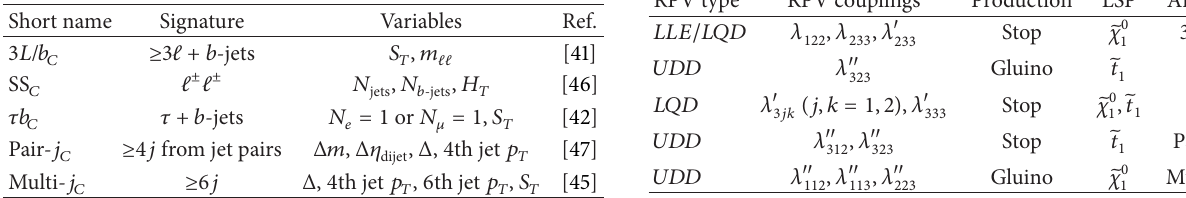
Table 3: Overview of CMS analyses constraining prompt RPV models. The signature descriptions are indicative only, and the reader is referred to the analysis documentation for further details in each case.